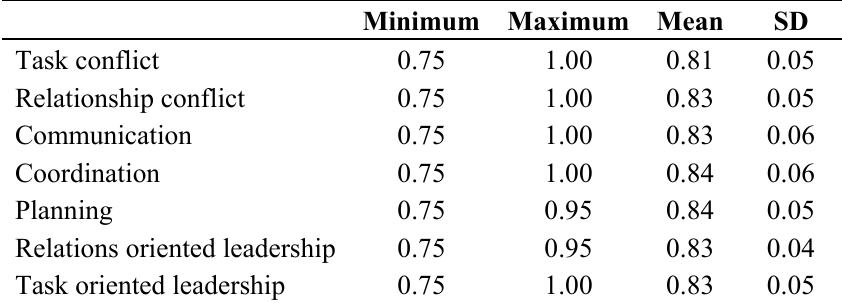
Table 1. Within Group Agreement Indices ( Rwg ).